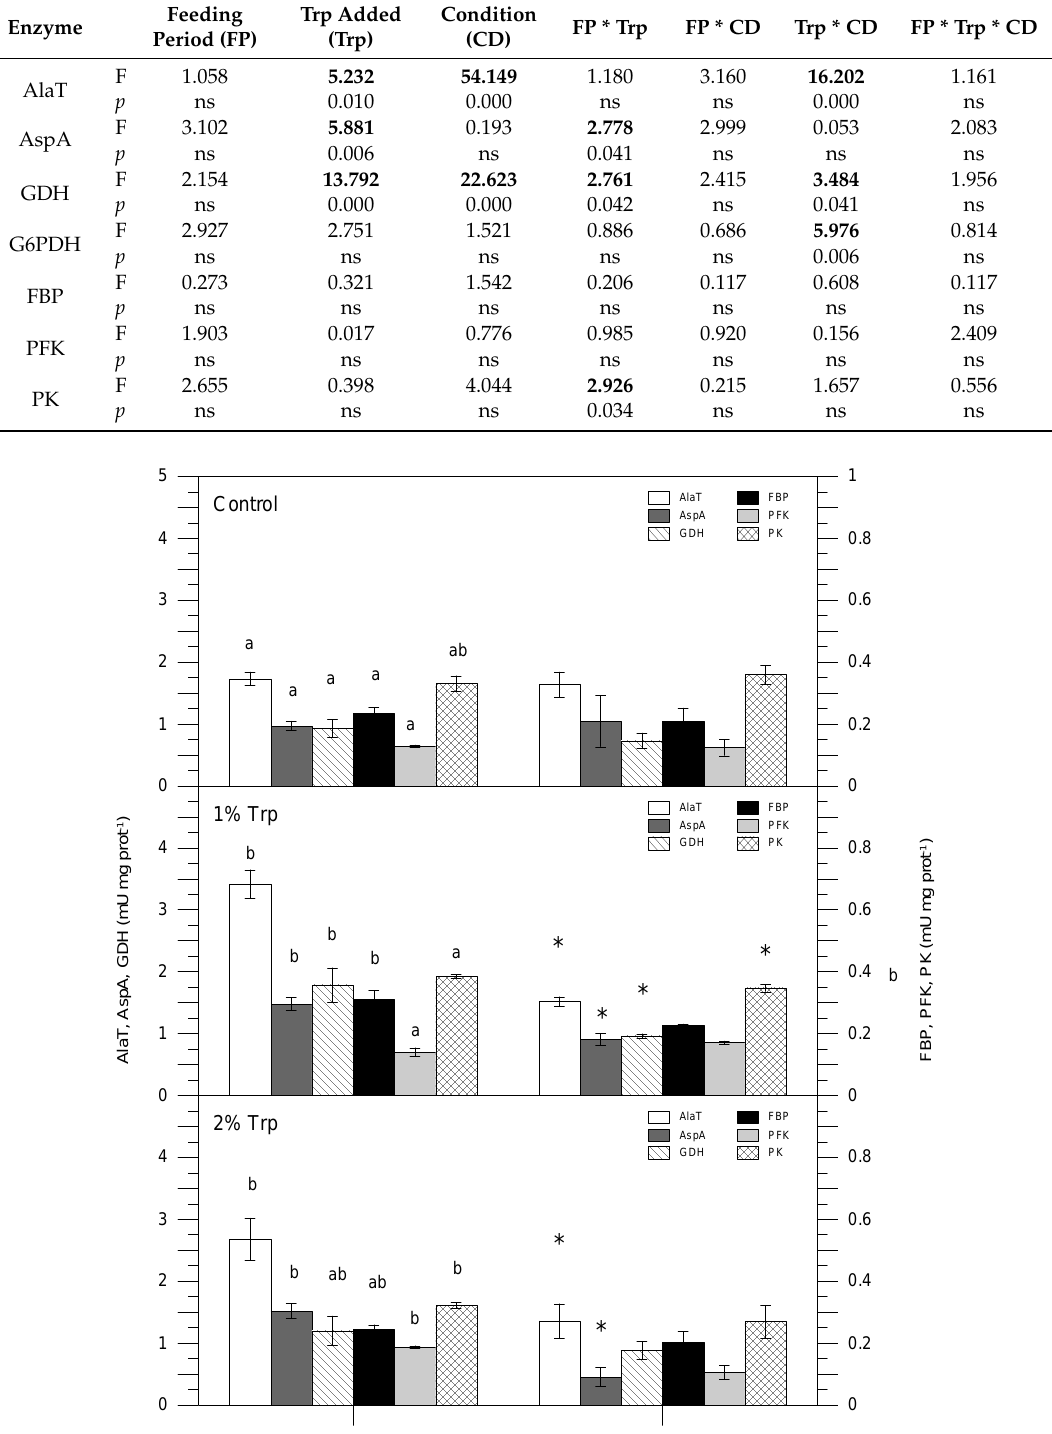
Table 3. Three-way ANOVA parameters ( α = 0.05) for enzyme activities. Factors are feeding time (2 / 8 days treatment), Trp added (control / 1% / 2%) and condition (pre- / post-stress); ns = no significant. F is in bold when effects are significant.